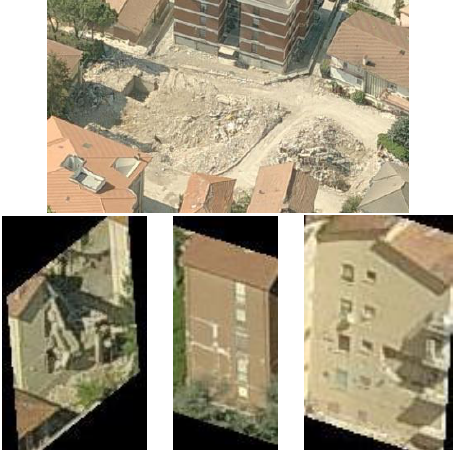
Figure 1. Top: example of two completely collapsed buildings. Below: examples of extracted facades. Left, partially collapsed building. Right and centre, two damaged facades with spalling Figure 2. Oblique view over L’Aquila, narrow streets and high